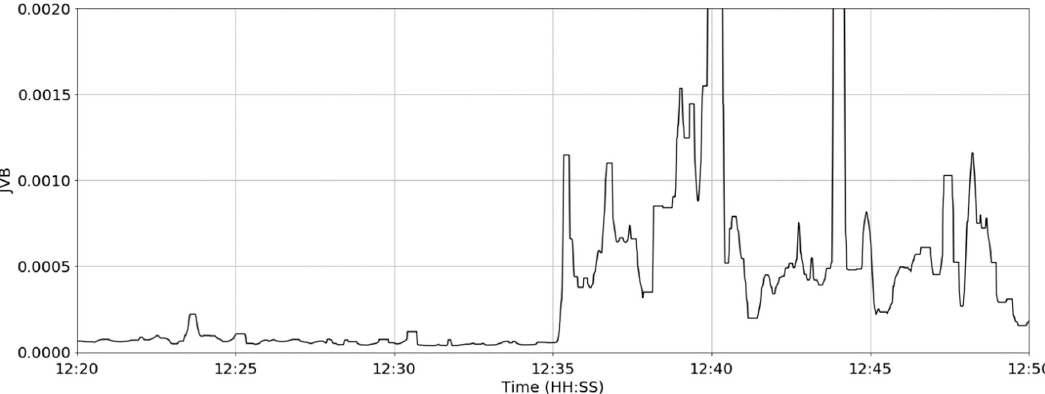
Figure 10. The Jerk Variance Baseline (JVB) signal.